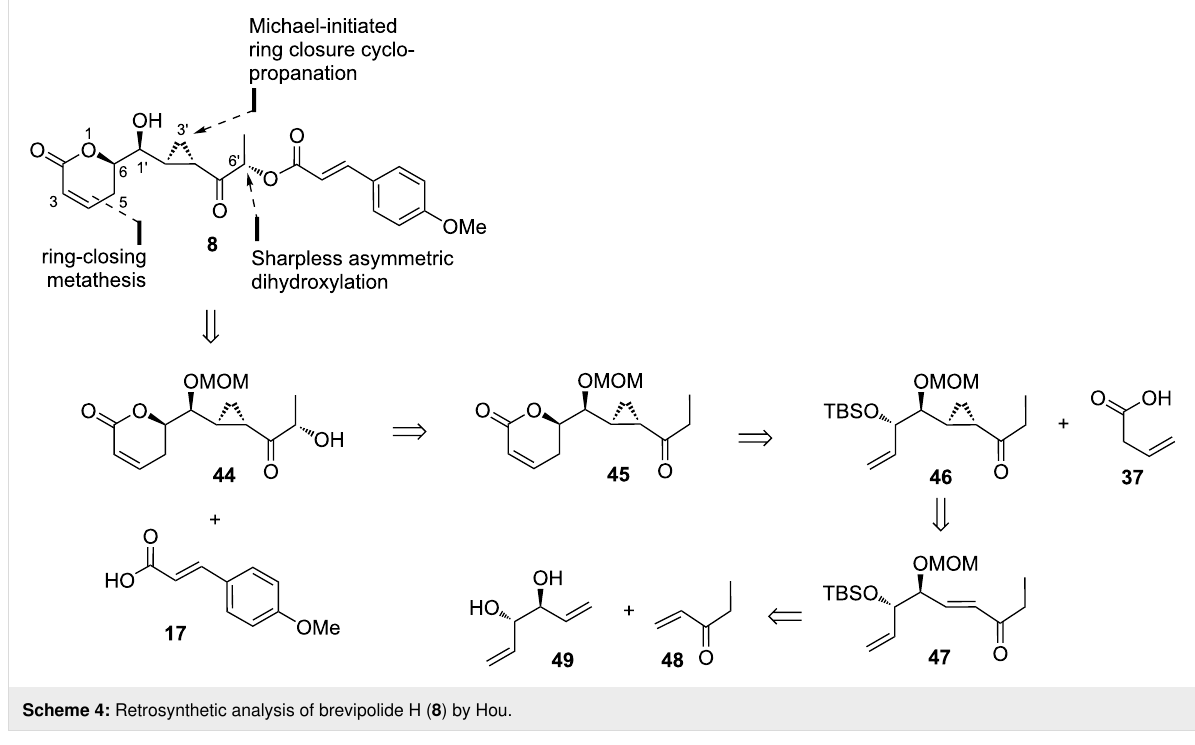
Scheme 4: Retrosynthetic analysis of brevipolide H ( 8 ) by Hou.